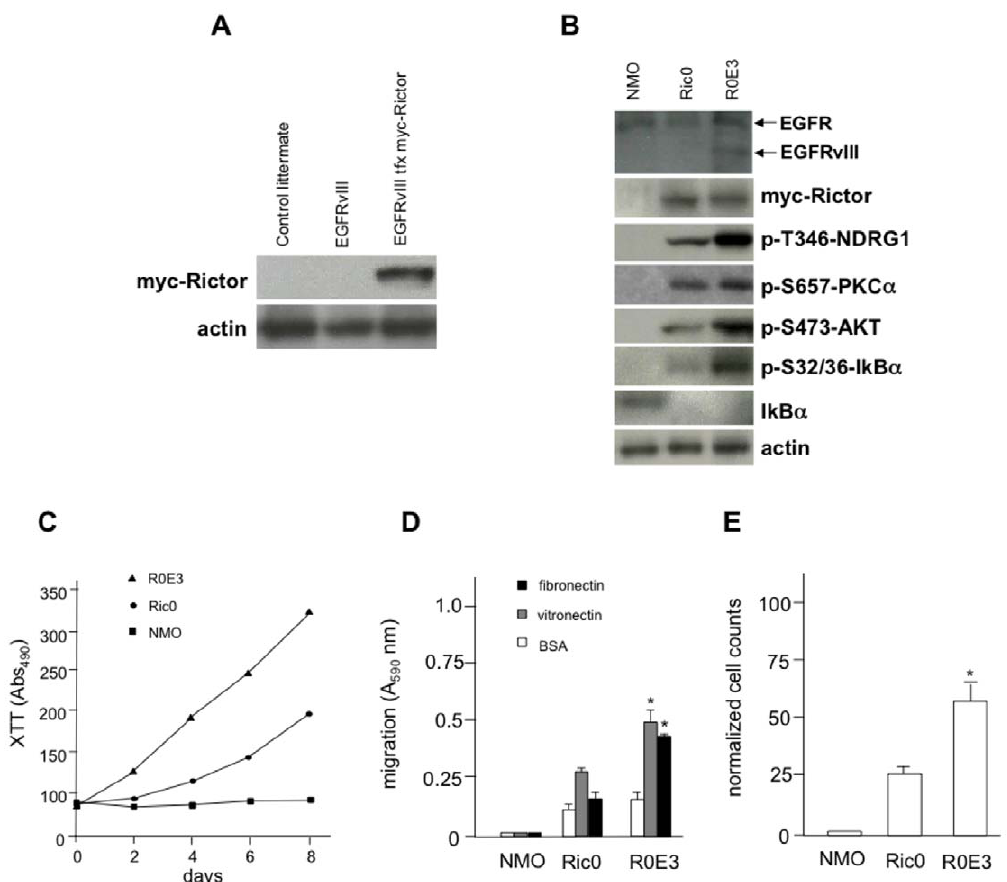
Figure 5. Cooperative signaling between oncogenic EGFR and mTORC2 results in enhanced gliomagenesis invitro . (A) Immunoblot analysis for myc-tagged Rictor in oligodendrocytes obtained from control littermates, GFAP-EGFRvIII, or GFAP-EGFRvIII; GFAP-Cre/Rictor loxP/loxP mice. (B) Cell line established from GFAP-EGFRvIII; GFAP-Cre/Rictor loxP/loxP oligodendroglioma (R0E3) displays elevated mTORC2 signaling in comparison to Ric0 cells. Lysates of normal mature oligodendrocytes (NMO), Ric0 and R0E3 cells were immunoblotted for the indicated proteins. (C) XTT proliferation assay of established normal mature oligodendrocytes (squares), transgenic Ric0 (circles) and R0E3 (triangles) cells. (D) Motility of NMO, Ric0 and R0E3 cells in Boyden chamber assays migrating towards, BSA (white bars), vitronectin (grey bars) or fibronectin (black bars), (*, P , 0.05) (E) Invasive potential of NMO, Ric0 and R0E3 cells in matrigel invasion assay (*, P , 0.05). Counts were normalized to the viable cell count to exclude any effects of increased cell number on transmigration. The data shown in (D&E) are the mean + S.D. of three independent experiments.